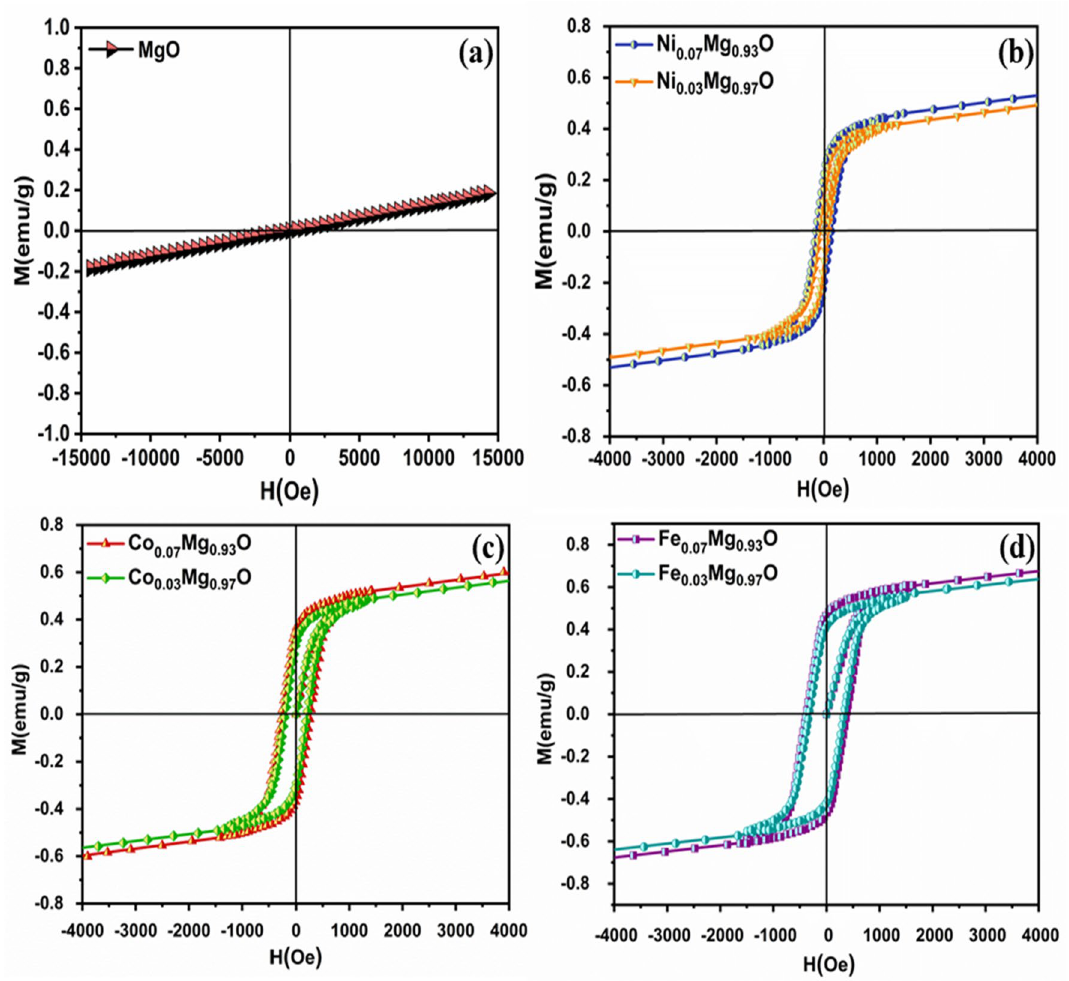
Figure 12. Magnetization hysteresis (M-H) curve of ( a ) pure (MgO), ( b ) 3% and 7% Ni-doped MgO, ( c ) 3% and 7% Co–MgO, and ( d ) 3% and 7% Fe-doped MgO nanoparticles measured at room